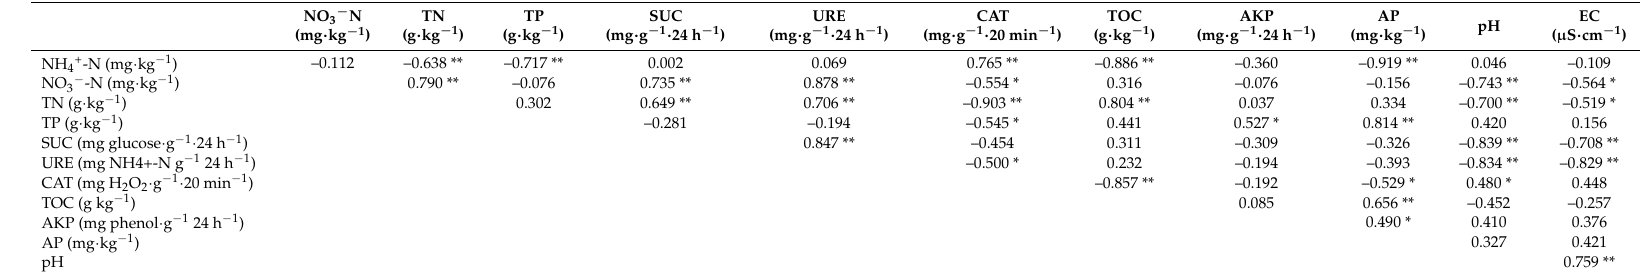
Table 4. Pearson correlation matrix for sediment variables sampled under simulated temperature